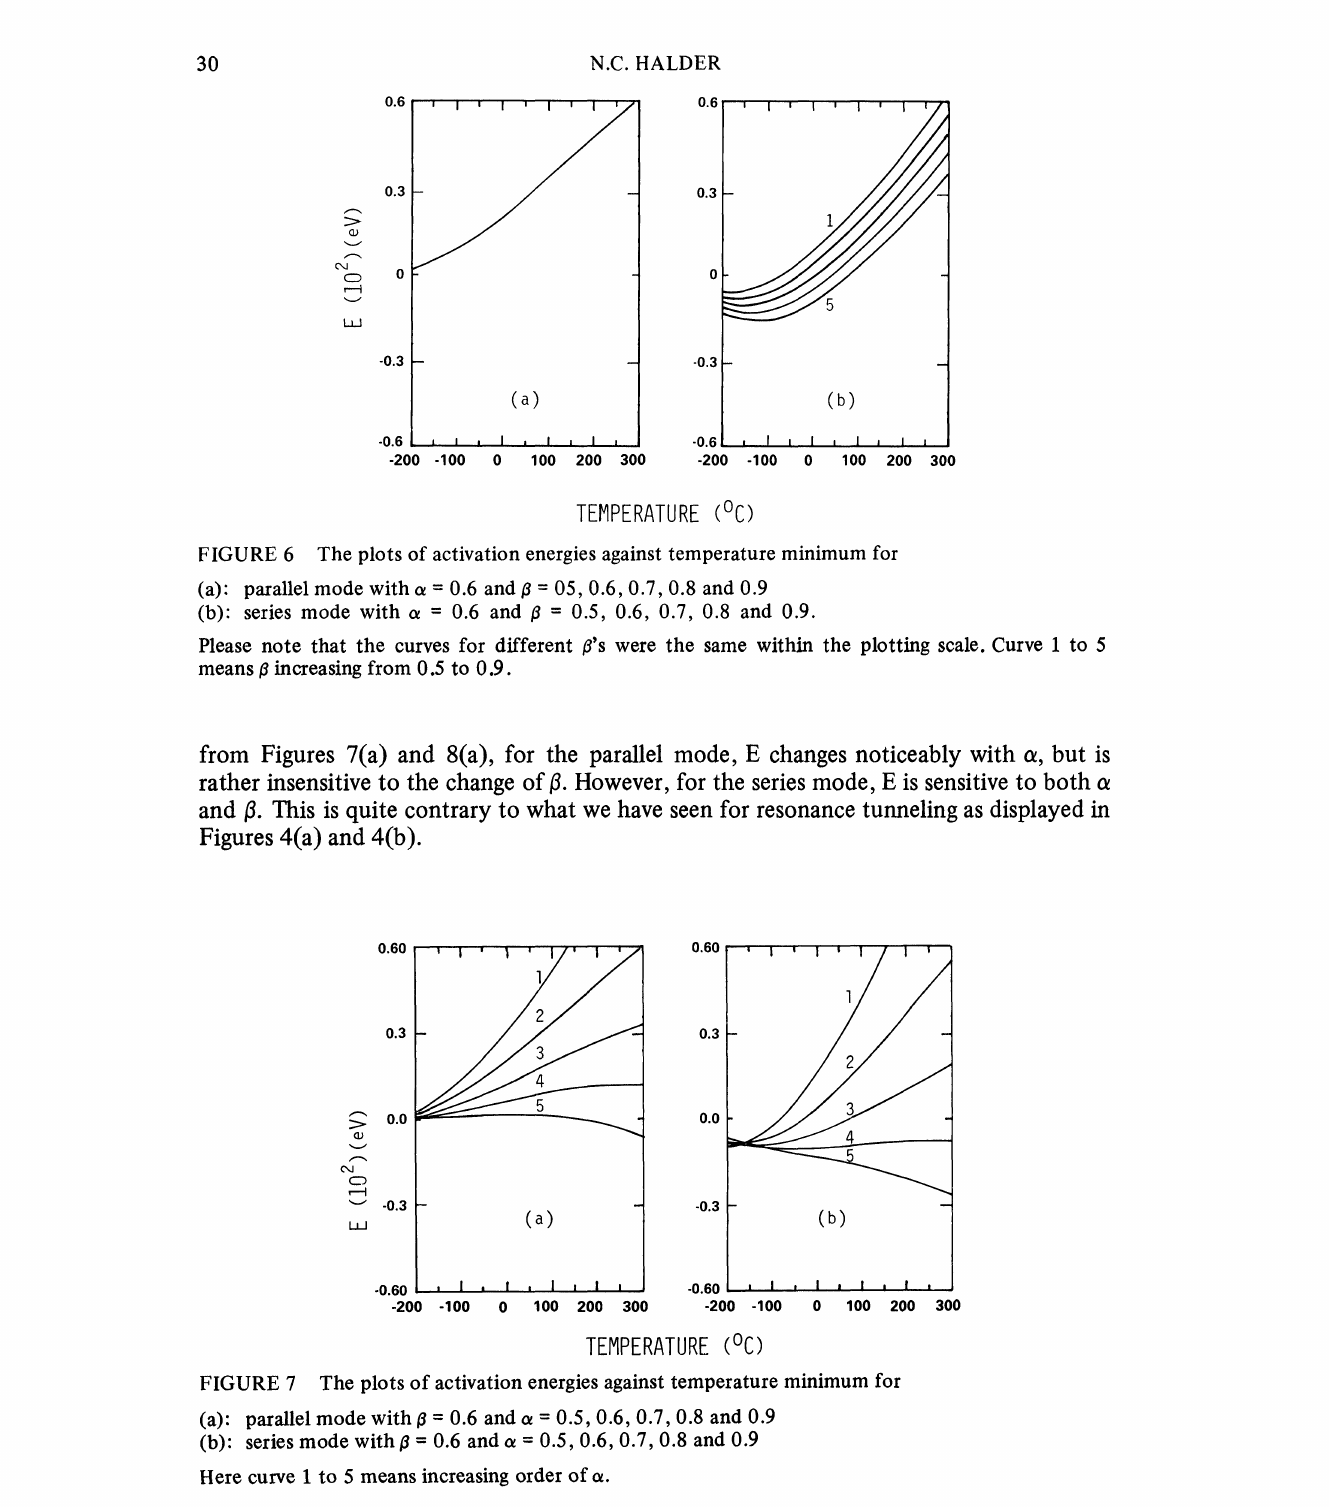
FIGURE 7 The plots of activation energies against temperature minimum for (a): parallel mode with/3 0.6 and a 0.5, 0.6, 0.7, 0.8 and 0.9 (b): series mode with/3 0.6 and a 0.5, 0.6, 0.7, 0.8 and 0.9 Here curve 1 to 5 means increasing order of